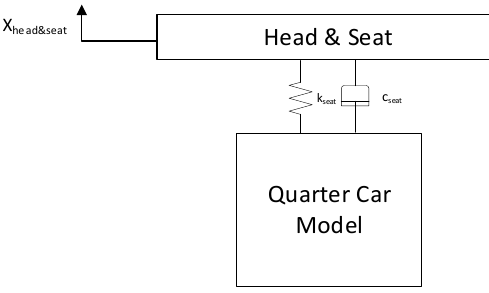
Figure 2. The three DOFs VSH model.